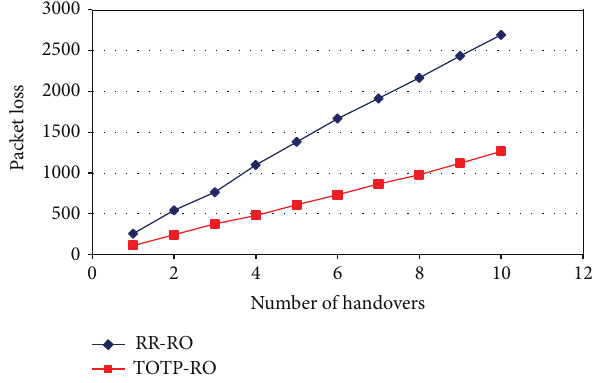
Figure 9: Handover delays comparison.